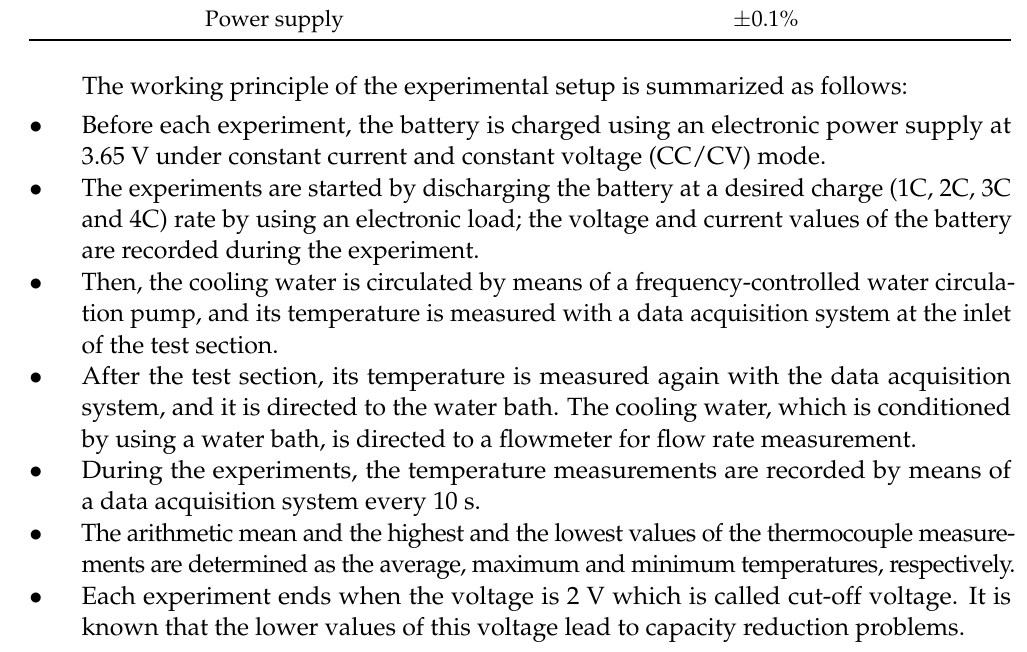
Figure 3. The variation of voltage with time for different discharge rates.